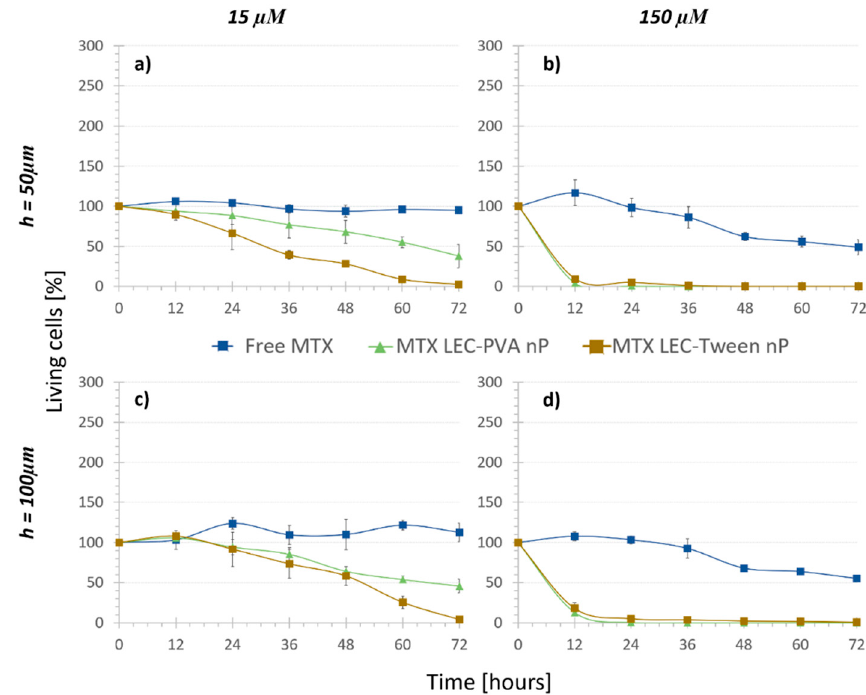
Figure 4. Total cytotoxic effect of LEC ‐ PVA nanoparticles (nP) at 15 μ M concentration inside 100 ‐ μ m high platforms, showing the components e 1 and e 2 of term E defined in this study.